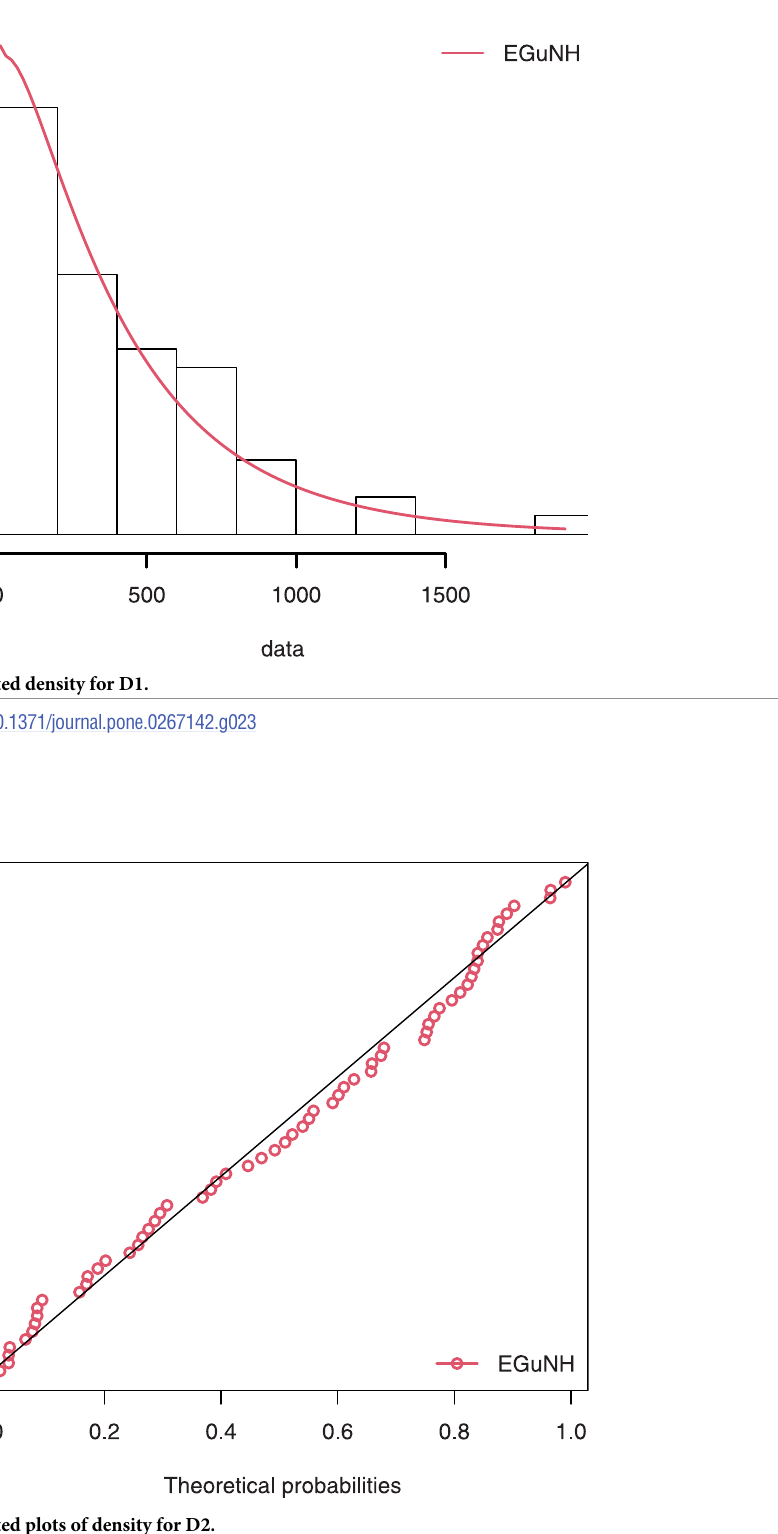
Fig 24. Estimated plots of density for D2.